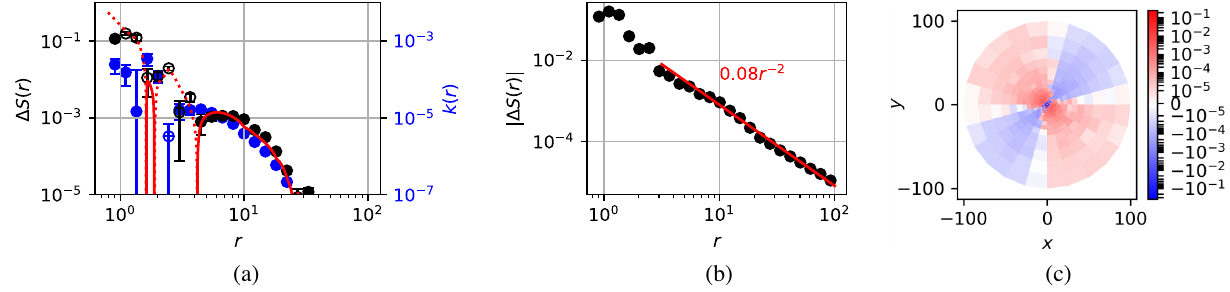
FIG. 6. (a) Mean softness change Δ S per frame caused by a rearranging particle at the origin. A prediction from Eq. (5) is plotted as red lines. Here we also plot the volumetric strain k ð r Þ for comparison. Similar to Fig. 3, solid dots and solid lines represent positive values, while hollow circles and dotted lines represent negative values. (b) Same as (a), but for its absolute value. (c) Mean softness change with directional dependence